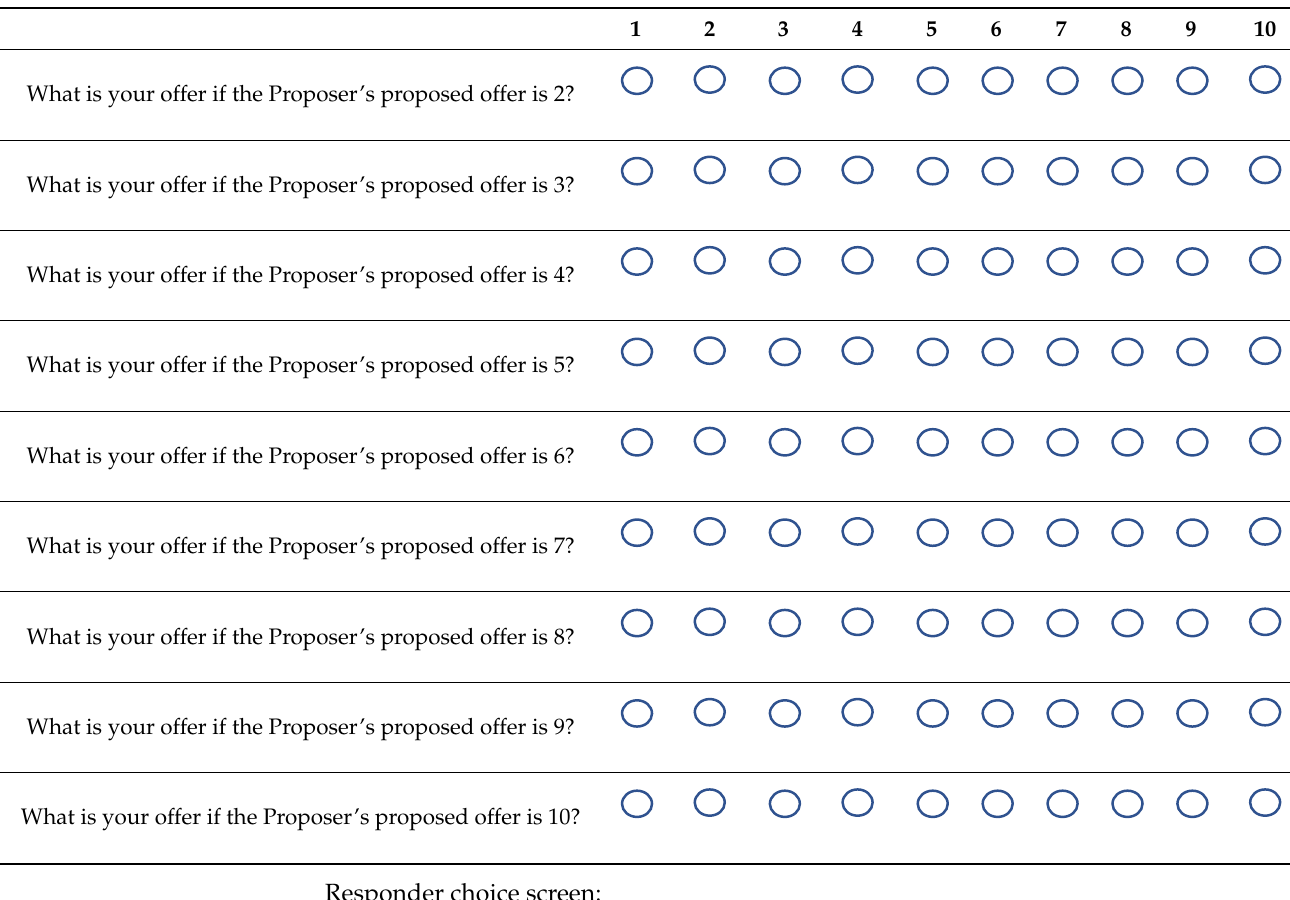
Table A1 . Accounting for the agent’s own proposal when he is in proposer’s role, in addition to the partnered proposer’s proposal. Estimates for linear regression of agent’s response function for non ‐ binding setting proposal (where there are no limits), Upper Bound, and Lower Bound, and pooled settings. Right and left censoring was conducted via Tobit in Upper Bound and Lower Bound set ‐ tings and in the pooled setting. Robust standard errors (N = 40) are reported in all cases.